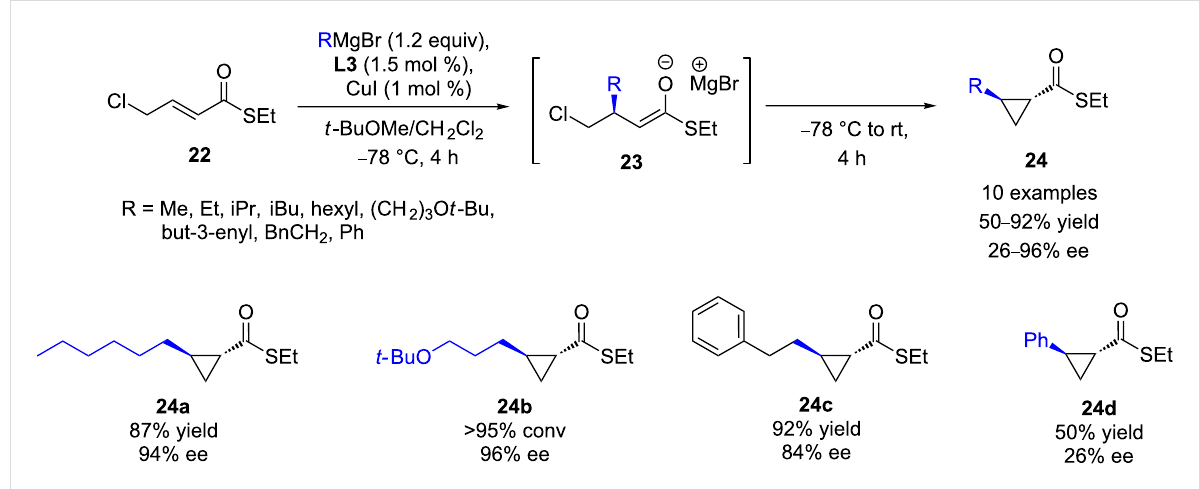
(50–82%) and ee values (82–98%). Unfortunately, ortho